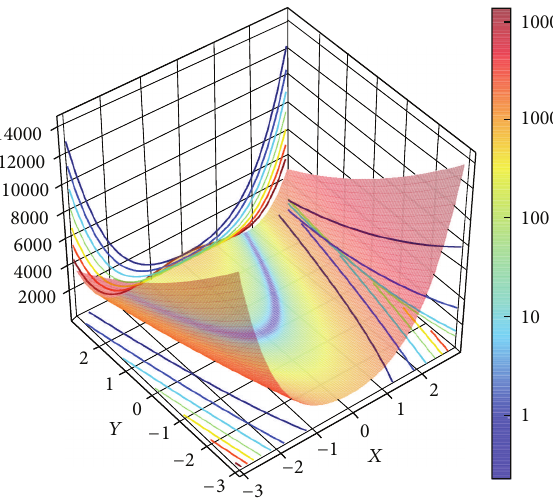
Figure 1: Rosenbrock’s valley is illustrated here in two dimensions. Notice the parabolic valley that includes the global optimum at [1,1] .